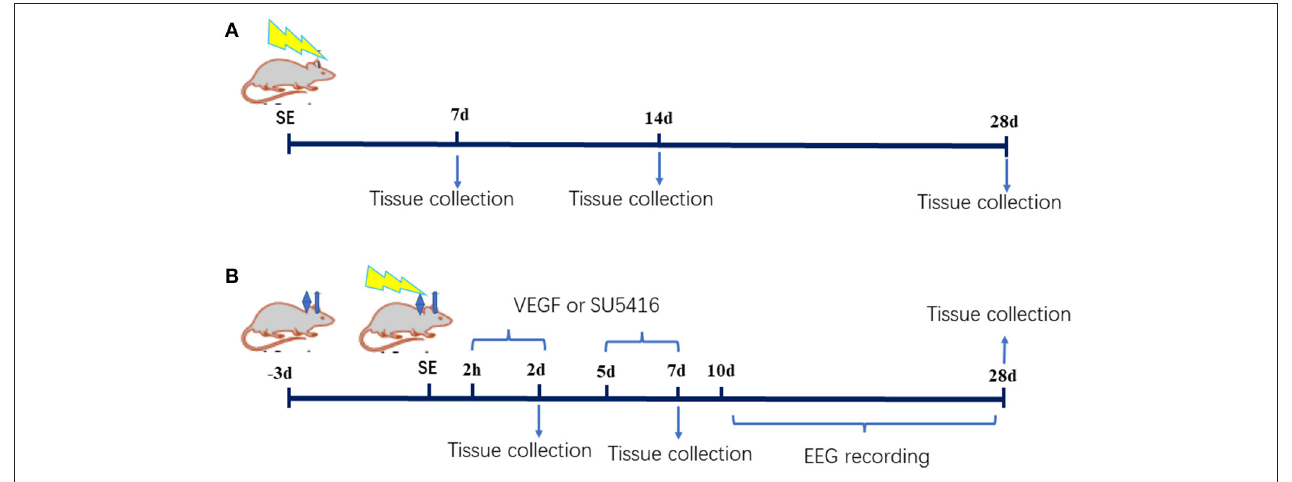
FIGURE 1 | Animal experiment procedure. (A) The first part (B) the second part.